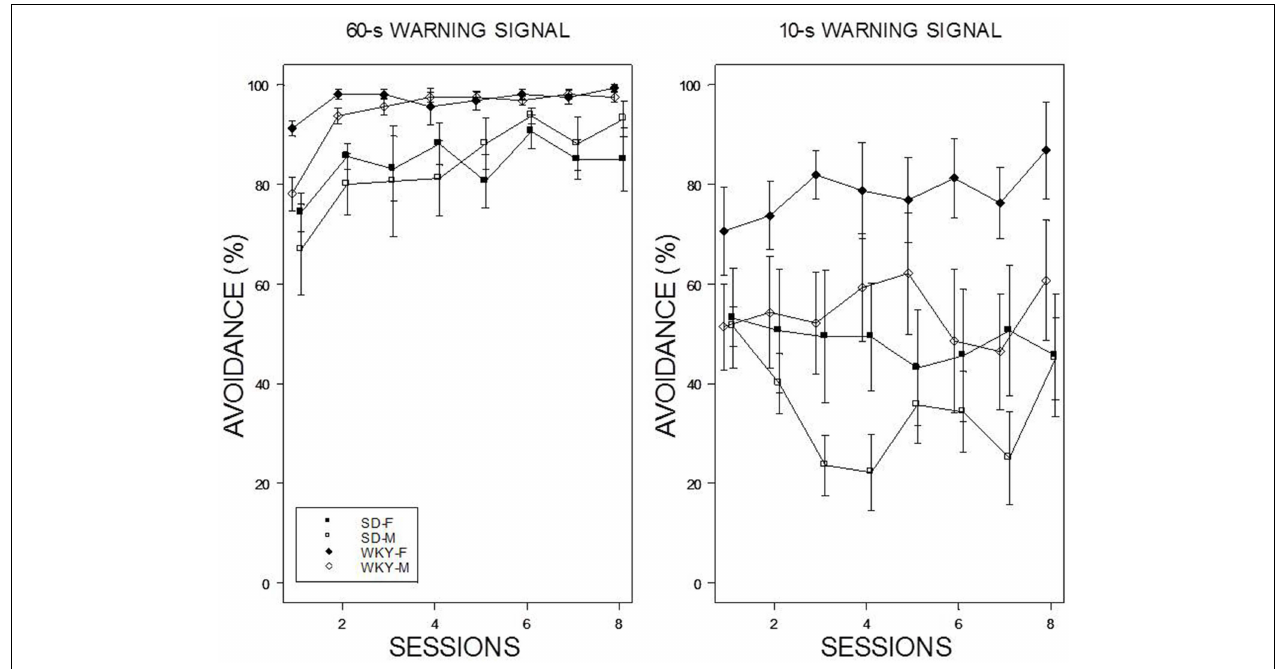
switched to 60-s WS, with slight increases over training. WKY rats expressed avoidance to a higher degree the SD rats. More modest levels of avoidance were expressed by rats initially trained with a 60-s WS but switched to a 10-s WS. Female WKY expressed avoidance to a higher degree than all other groups. Male SD rats decreased avoidance expression over